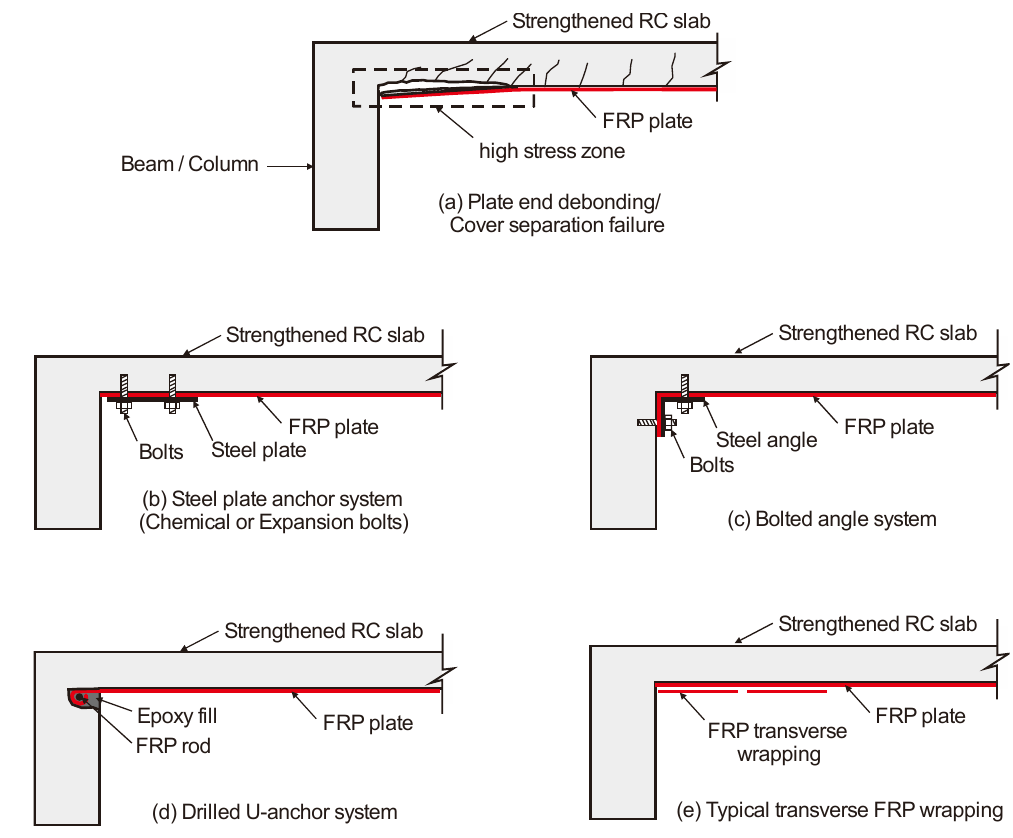
Figure 2. Schematic anchorage systems of EBR of RC slabs using FRP plate. ( a ) Plate end debond- ing/Cover separation failure; ( b ) Steel plate anchor system (Chemical or Expansion bolts); ( c ) Bolted angle system; ( d ) Drilled U-anchor system; ( e ) Typical transverse FRP wrapping